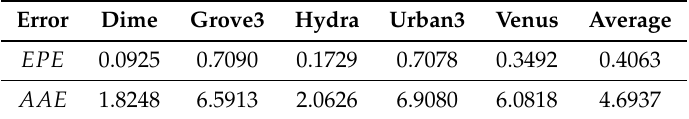
Table 7. Obtained results of our model in Middlebury with κ = 0.0.